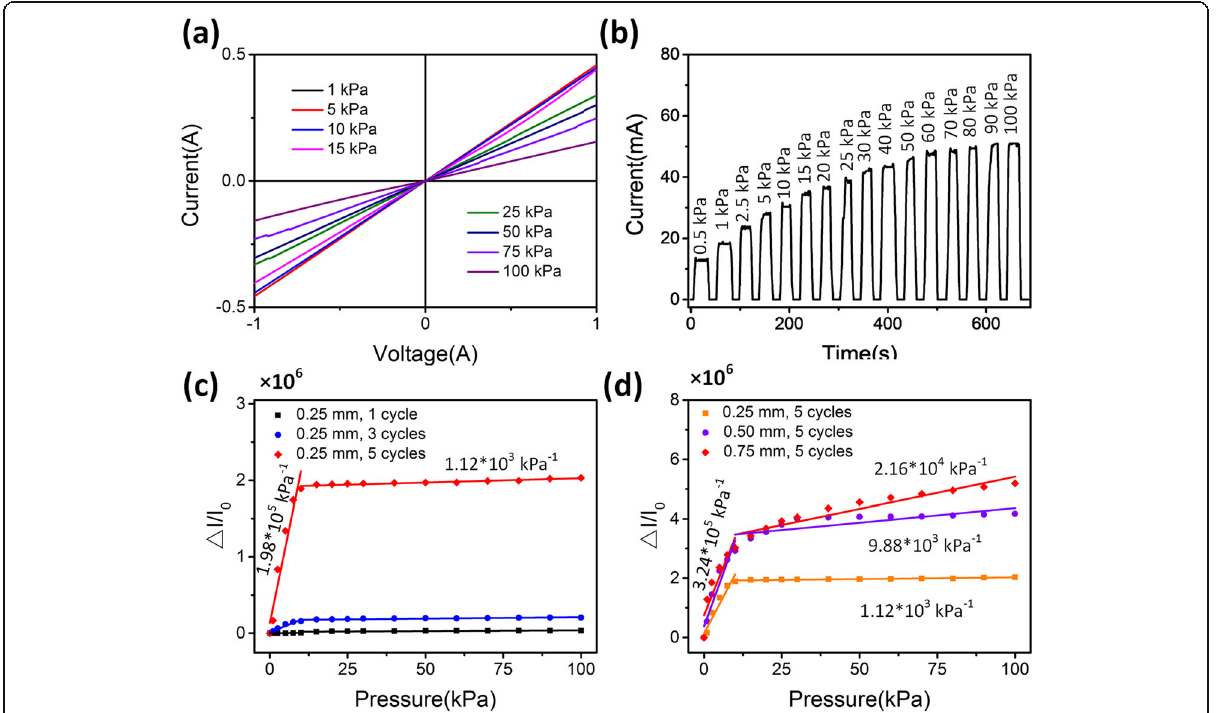
Fig. 4 Performances of the pressure sensors. a I-V curves of the pressure sensor with different applied pressures. b The current response of the sensor under different pressures. c , d The performance comparison of the pressure sensors with different dip-coating cycles and mesh hole